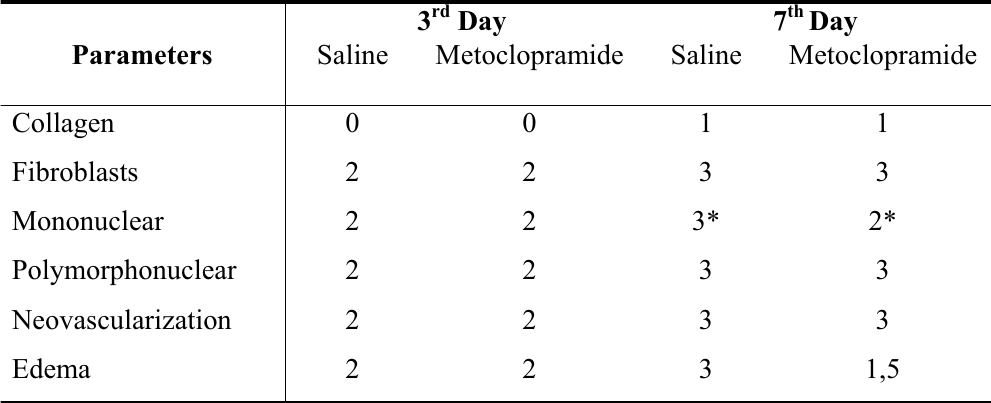
TABLE 5 - Median of values of the histological parameters by